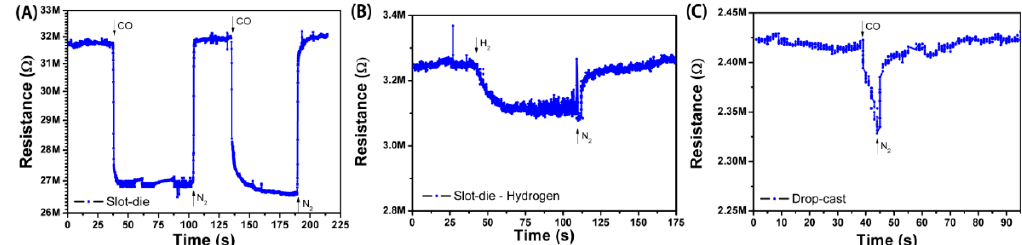
Figure 7. Detection curves for: ( A ) slot-die coated film of SnO 2 -rGO against CO; ( B ) slot-die coated film of SnO 2 -rGO against H 2 ; ( C ) drop-cast film of SnO 2 -rGO against CO.